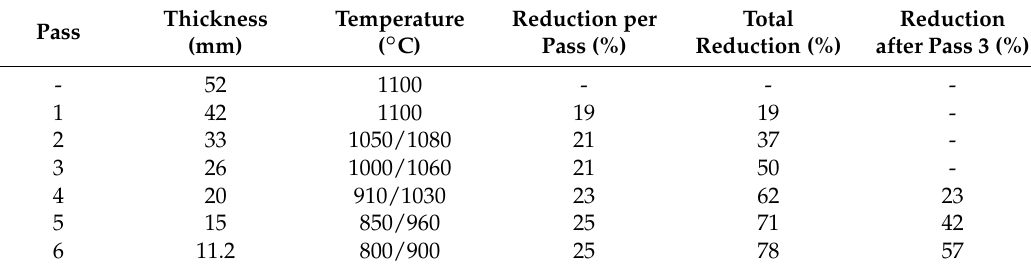
Table 2. Hot rolling pass schedules giving finish rolling temperatures (FRTs) of 800 and 900 ◦ C.